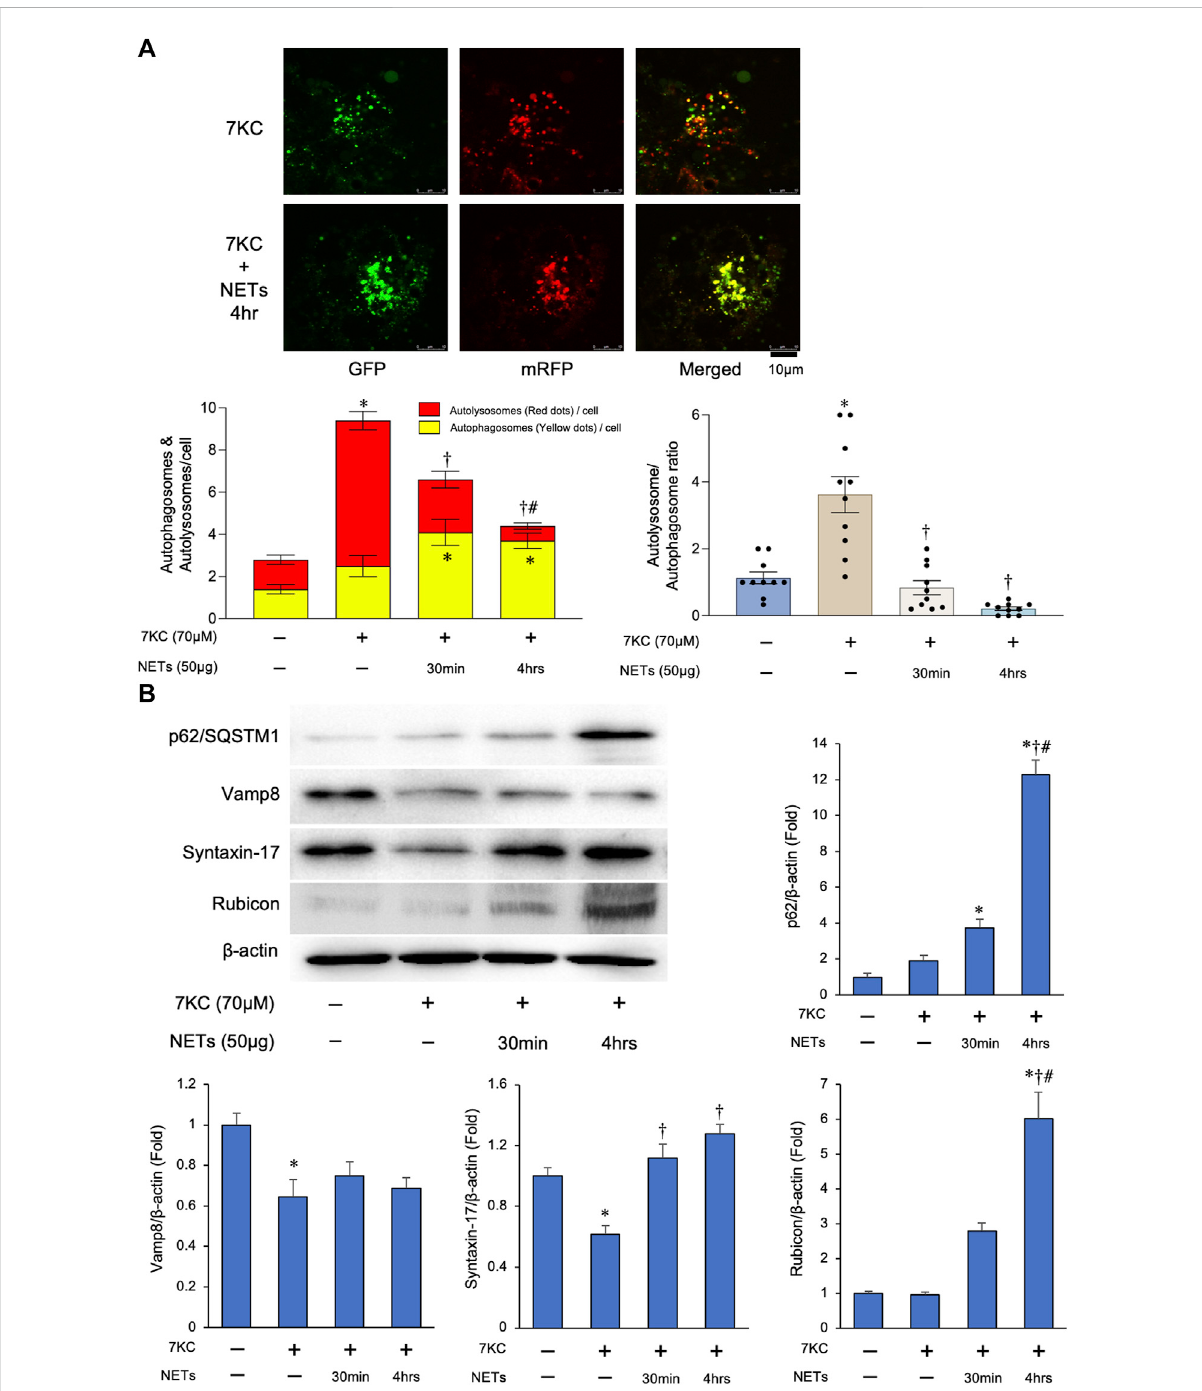
FIGURE 5 NETsnegativelyregulateautophagosome – lysosomefusionthroughupregulatingRubiconexpression. (A) Autophagy fl uxassay.Macrophagesderived fromtheTHP-1cellsweretreatedwitha7KCafterAd-tf-LC3transductionandthentreatedwithorwithouttheNETs.Upperpanels : Representativeimagesof the fl uorescentLC3puncta.Punctawithayellowcolorinthemergedimagesindicatetheautophagosomes,andpunctawithredcolorinthemergedimages indicate autolysosomes. Left lower panel: Quantitative analysis of the mean number of autophagosomes represented by the yellow puncta in the merged images and autolysosomes represented by the red puncta in the merged images per cell is shown. * p < 0.05 vs. control group, † p < 0.05 vs. 7KC- treated group, # p < 0.05 vs. 7KC + NETs (30 min)-treated group, n = 10 in each group. Data are expressed as the bars, with the lines indicating the mean ± SEM. Right lower panel : Quantitativeanalysis of the meanautophagosome/autolysosome ratio per cell is shown. * p < 0.05vs. control group(Blue bar), † p < 0.05vs.7KC-treatedgroup(Brownbar), n =10ineachgroup.Dataareexpressedasdotplotsandbars,withlinesindicatingthemean±SEM. (B) Leftupper panel:Representativeimmunoblotimagesofthep62/SQSTM1,Vamp8,Syntaxin-17,Rubicon,and β -actin.RightandLowerpanels:Densitometricanalysisof immunoblots. * p < 0.05 vs. control group, † p < 0.05 vs. 7KC-treated group, # p < 0.05 vs. NET (30 min)-treated group, n = 3 in each group. All data are expressed as mean ±